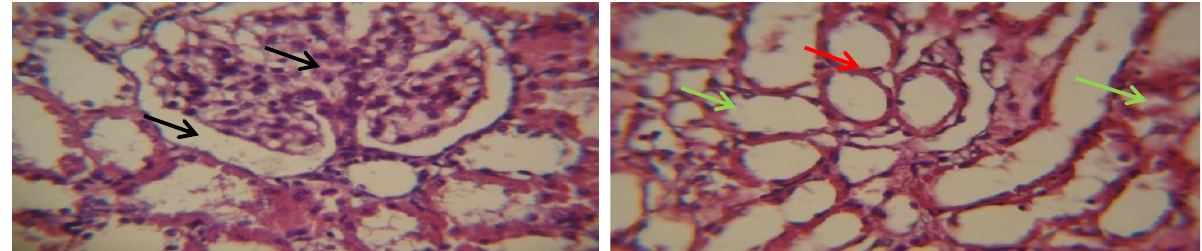
Figure 2. Histological section of kidney from control group shows normal renal medulla with normal renal tubules (black arrow) and normal renal cortex with normal glomerulus (red arrow) and renal tubules (green arrow). H&E 100× and 500×